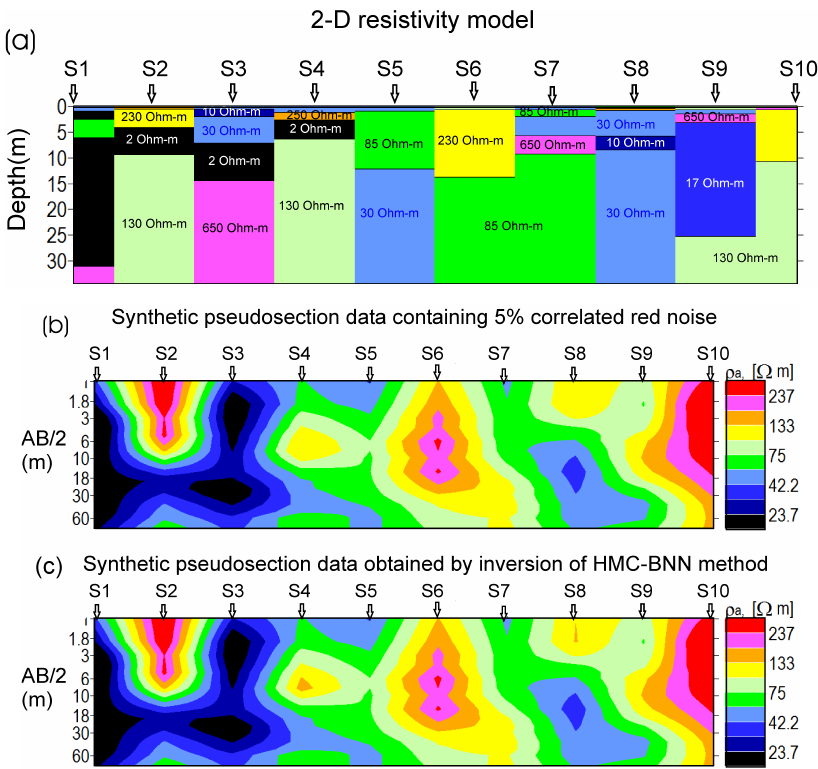
Fig. 8. Example to demonstrate two-dimensional (2-D) inversion of resistivity structure: (a) two-dimensional (2-D) model, (b) synthetic pseudosection data containing 5% correlated red noise, (c) synthetic pseudosection obtained by inversion of Hybrid Monte Carlo (HMC) based Bayesian neural network (BNN)